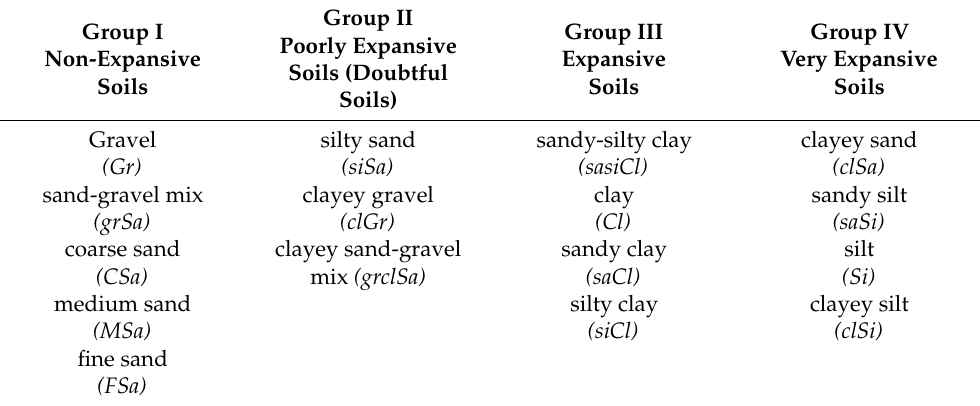
Table 2. General classification of soil types with regard to the phenomenon of freeze–thaw effects (symbols of soil names according to